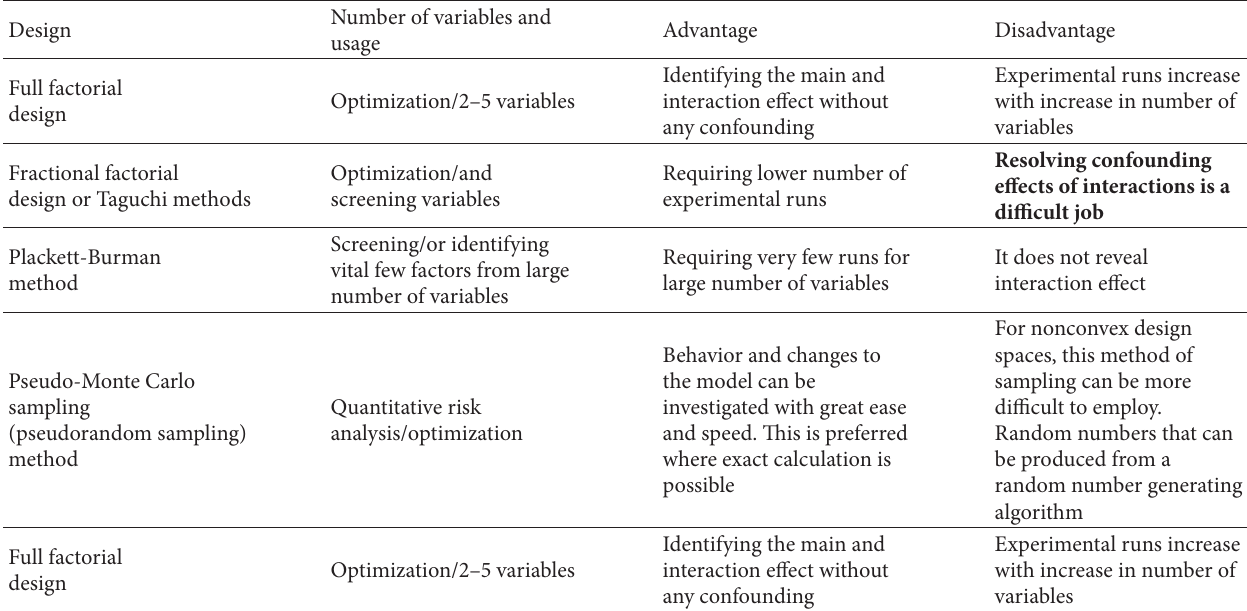
Table 5: Selection of DOE tools in analytical quality by